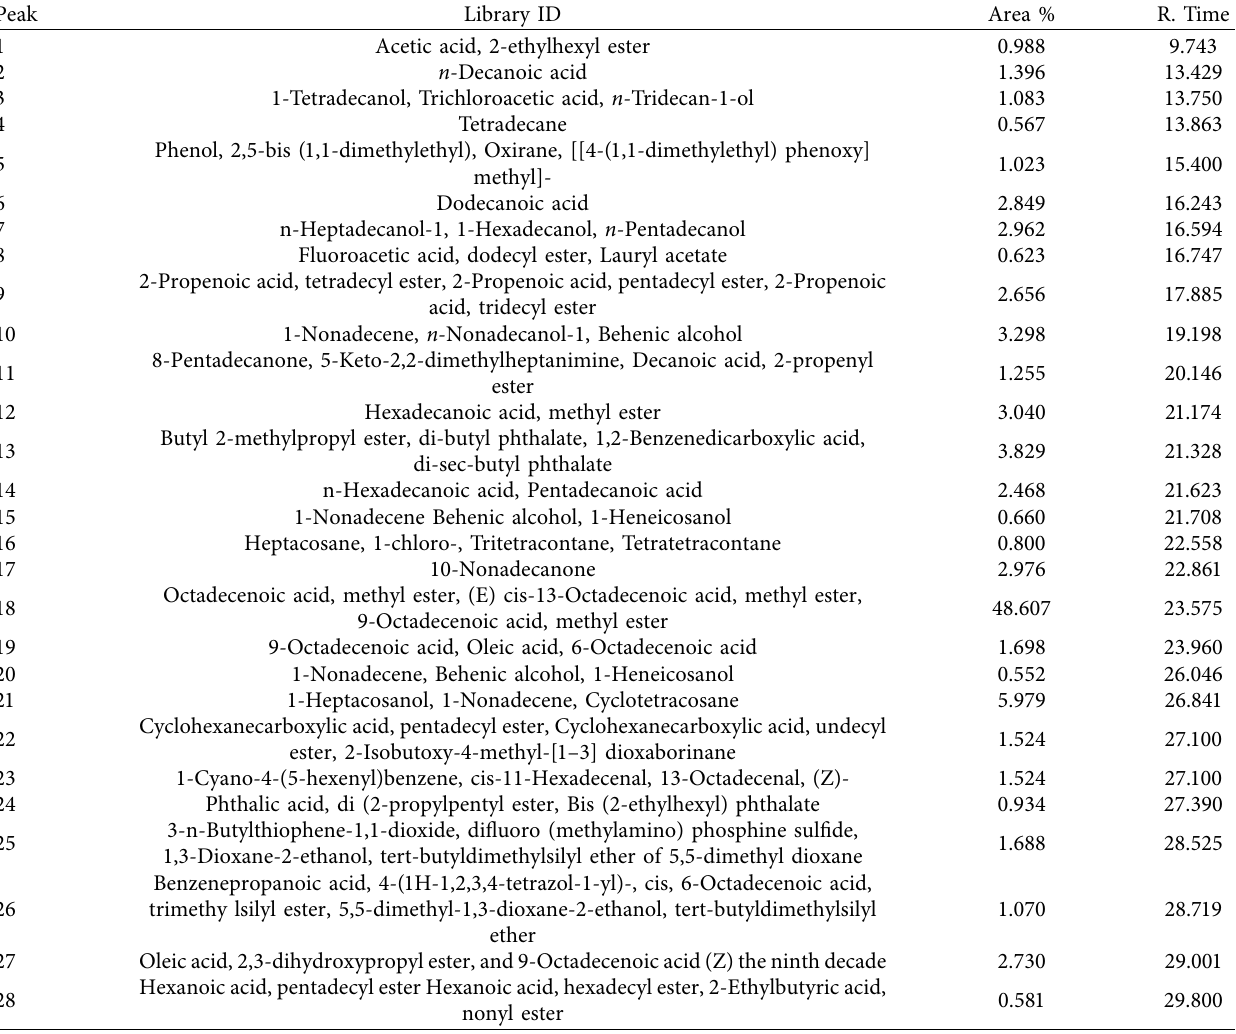
Figure 3: Antagonistic interaction between the endophytic Paecilomyces sp . and the pathogenic Rhizoctonia solani grown on PDA at 28 ° C for 7days. Table 2: Bioactive compounds identifed in the ethyl acetate extract of Paecilomyces sp. Data from NISTstandard reference database: NIST chemistry webbook